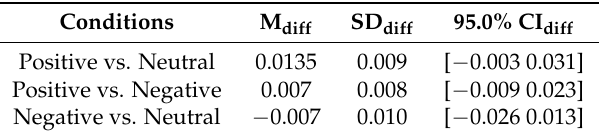
Figure A2. Paired two-sample bootstrap test (10,000 simulation runs) at 95.0% confidence interval (CI) associated with the participants’ PE3 values (i.e., 62 PE3s associated with 62 EEG channels of a participant, per affect). Compared pairs of mental states are ( A ) positive versus neutral, ( B ) positive versus negative, and ( C ) negative versus neutral. X-axis: difference between average values of two affective states (e.g., positive versus negative). Blue line: non-significant difference between PEs of two different affective states. Red lines: 95.0% confidence interval boundaries. Yellow line: average two affetective states’ mean differences over 10,000 simulations. Table A2. Paired two-sample bootstrap test (10,000 simulation runs) at 95.0% confidence interval (CI) applied on the participants’ PE3 values (i.e., 62 PE3s associated with 62 EEG channels of a participant, per affect). Compared pairs of mental states are: positive versus neutral, positive versus negative, and negative versus neutral. M: mean difference, SD: standard deviation of such a difference. CI: 95% confidence interval for every paired affective states’ difference.